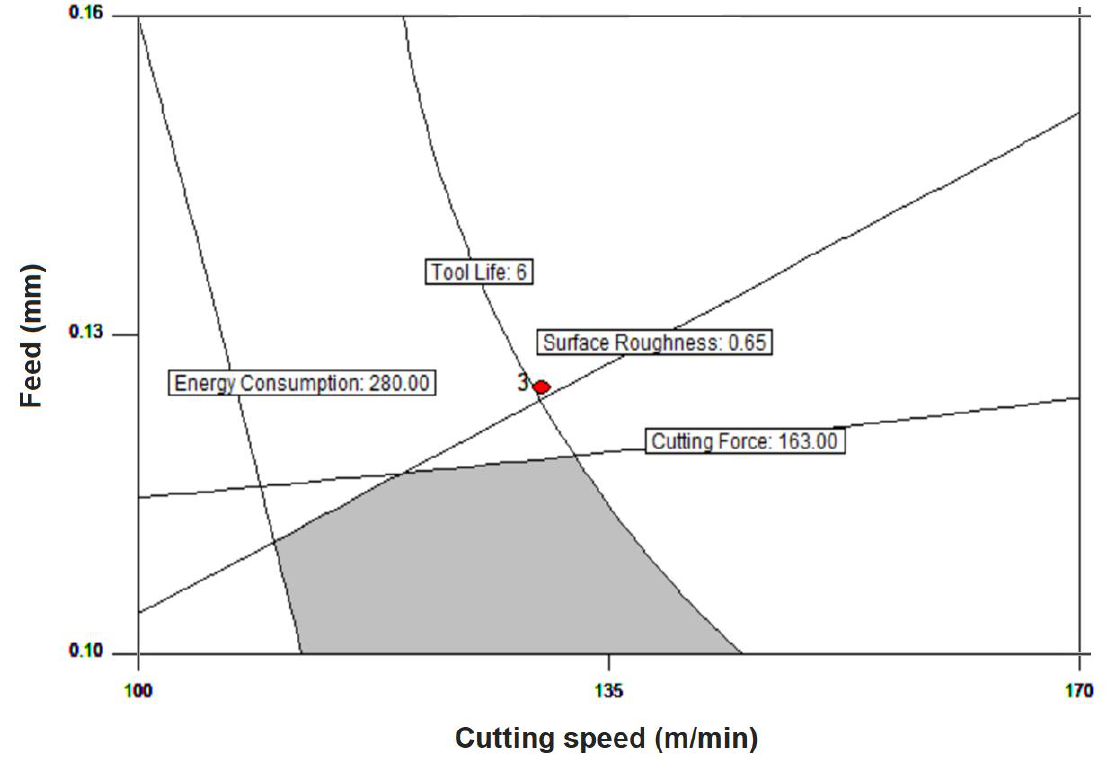
Figure 5. Overlay plot of the predetermined response criteria of T not less than 6 min, and Ra , F C, and E 2 of not more than 0.65 µ m, 163 N, and 280 kWs,